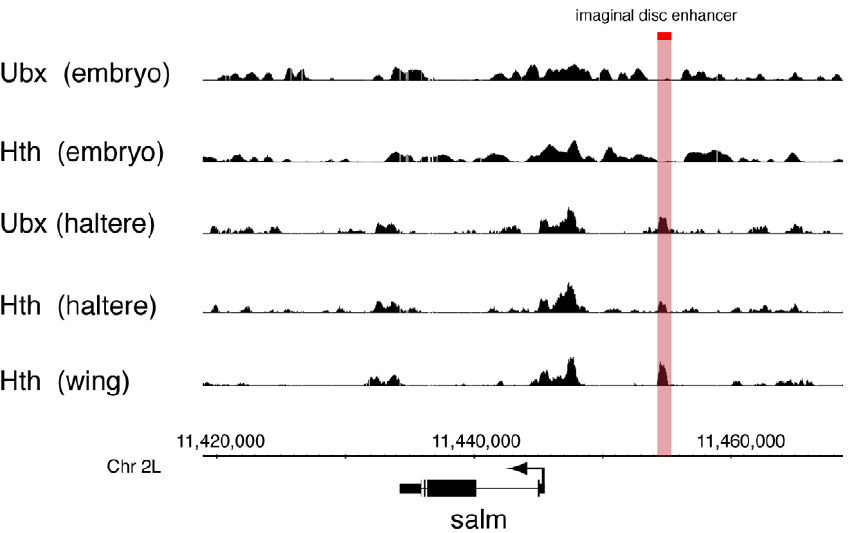
Figure 6. Ubx and Hth binding at salm. The red vertical indicates the imaginal disc enhancer identified by Galant et al. [21].